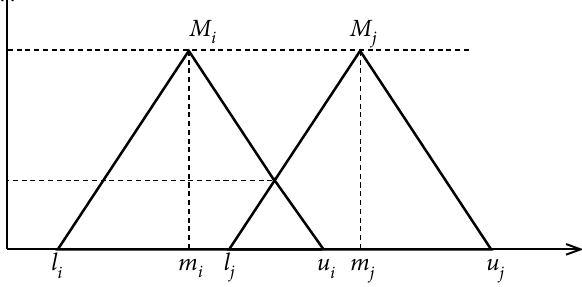
Fig. 2. Highest intersection point D between µ